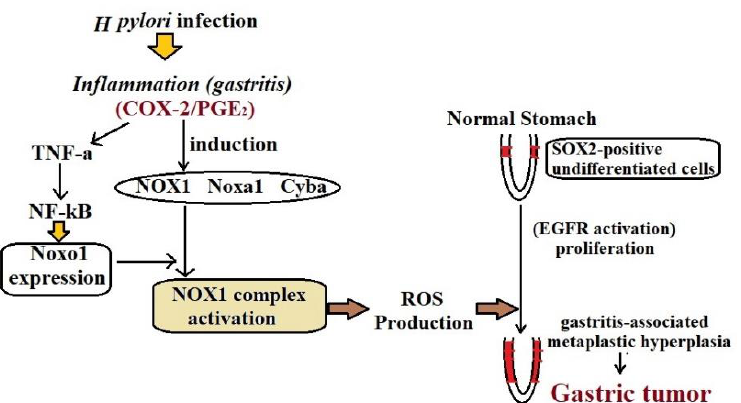
Figure 2. Role of Noxo1 and NOX1 in the gastric tumorigenesis in the H. pylori -infected stomach [17].